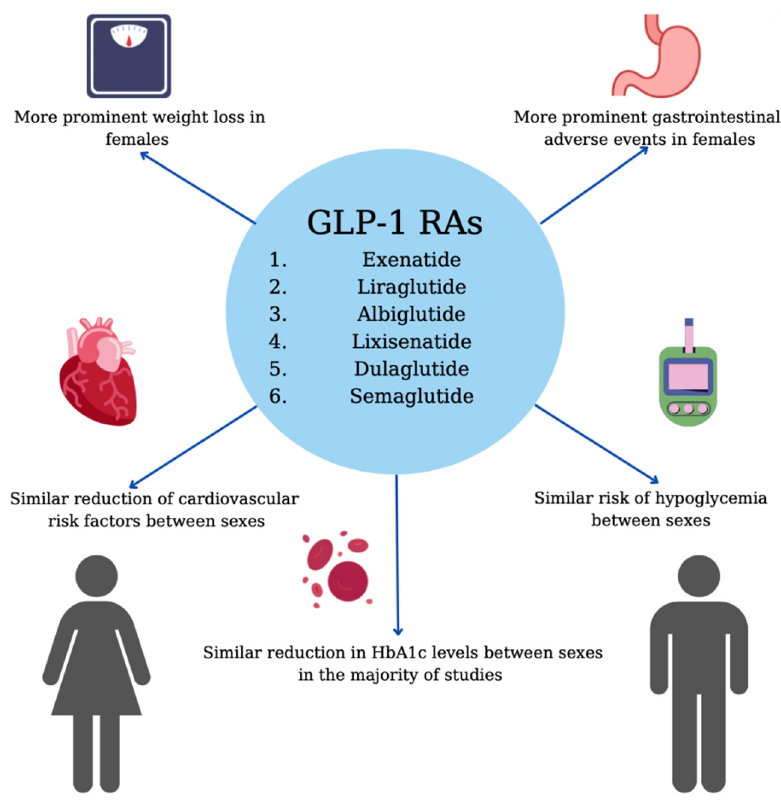
Figure 1. Sex-specific effects of GLP-1 RAs .